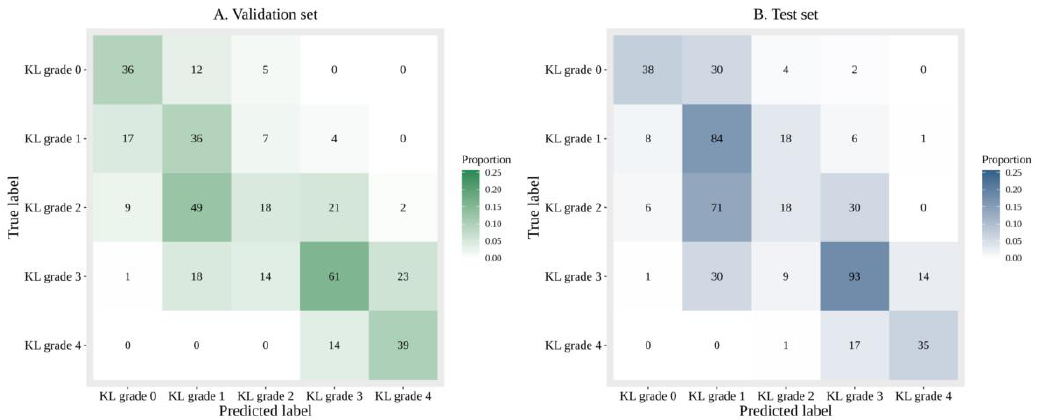
Figure 3. Confusion matrices of predicted and ground truth labels with sole image data.